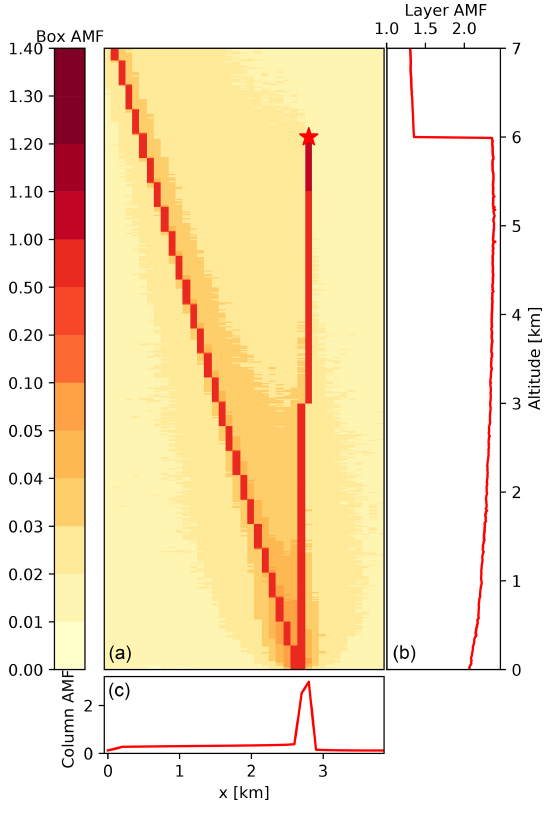
Figure 7. The 3D-box AMFs cross section at y = 1 . 4km for the aircraft scenario presented in this section. Aircraft (red star) placed at z = 6km, x = 2 . 9km and y = 1 . 4km pointing eastwards. The sun is at SAA = 90 ◦ (west) with a SZA of 20 ◦ . (b) Vertical profile of horizontally integrated AMFs (1D-layer AMFs). (c) Horizontal profile of vertically integrated AMFs (column AMFs). The default properties are a rural-type aerosol in the PBL, background aerosol above 2km, spring–summer conditions and a visibility of 50km.